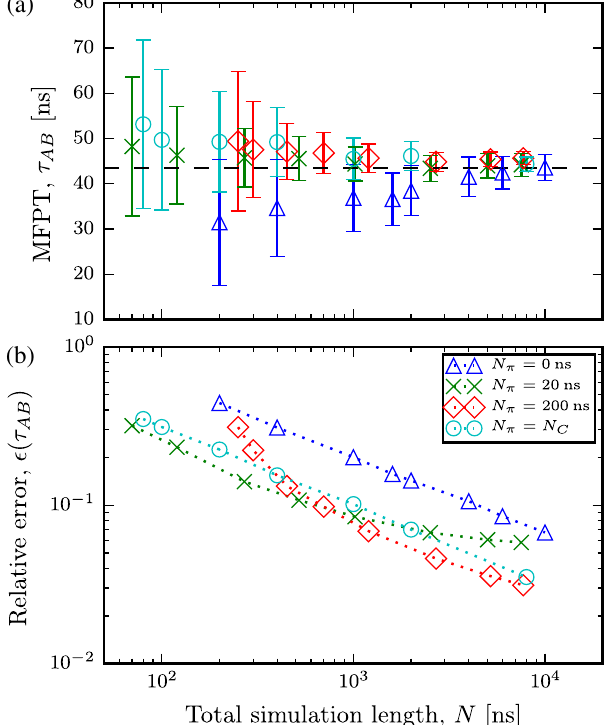
FIG. 9. Mean and standard error of MFPT τ AB , total simulation effort N , for alanine-dipeptide MSM on the ϕ dihedral angle alone. The mean first-passage time τ AB of the transition from the low free-energy region, A ¼ f ϕ j − 162 ° < ϕ < − 54 ° g , to the high free-energy region, B ¼ f ϕ j 36 ° < ϕ < 72 ° g , is used as an observable for a rare-event process. (a) Convergence of the mean value is shown for a small number of long chains starting in the A region (blue) and for an ensemble of short chains starting in the B region combined with different amounts of umbrella sampling simulations (green, red, light blue). The correct value, τ 43 ns, for the C α AB ¼ 5 to L transition can be obtained even if no information about the ψ dihedral angle is used in the construction of the MSM. (b) The standard error shows almost 1 order of magnitude speed-up when estimating the kinetic characteristic of a rare event τ AB using short trajectories in combination with umbrella sampling simulations compared to using long trajectories and no additional information about the equilibrium